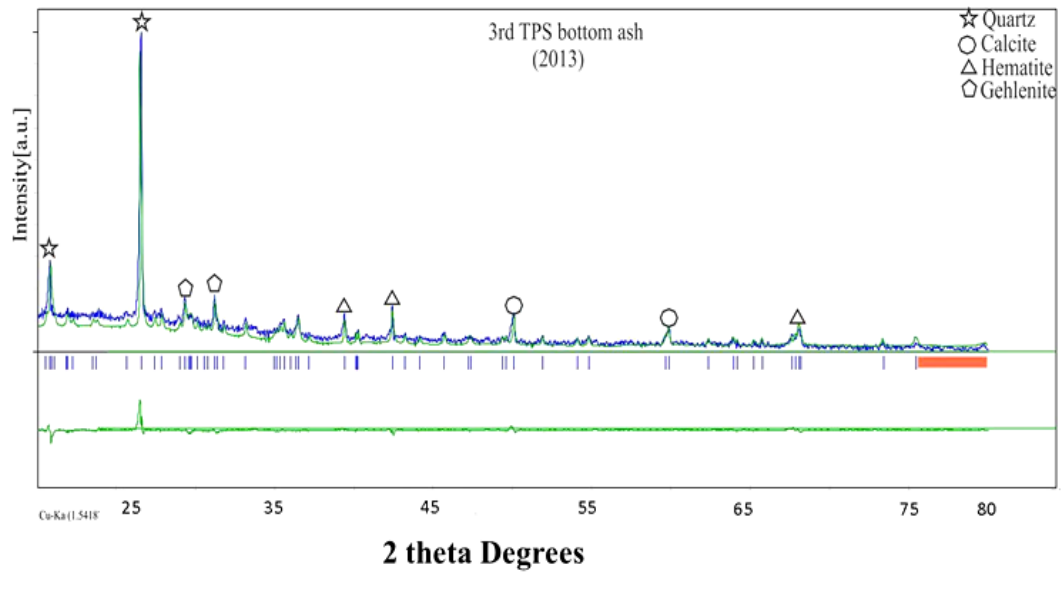
Fig. 4. XRD pattern of the ash collected in 2013.